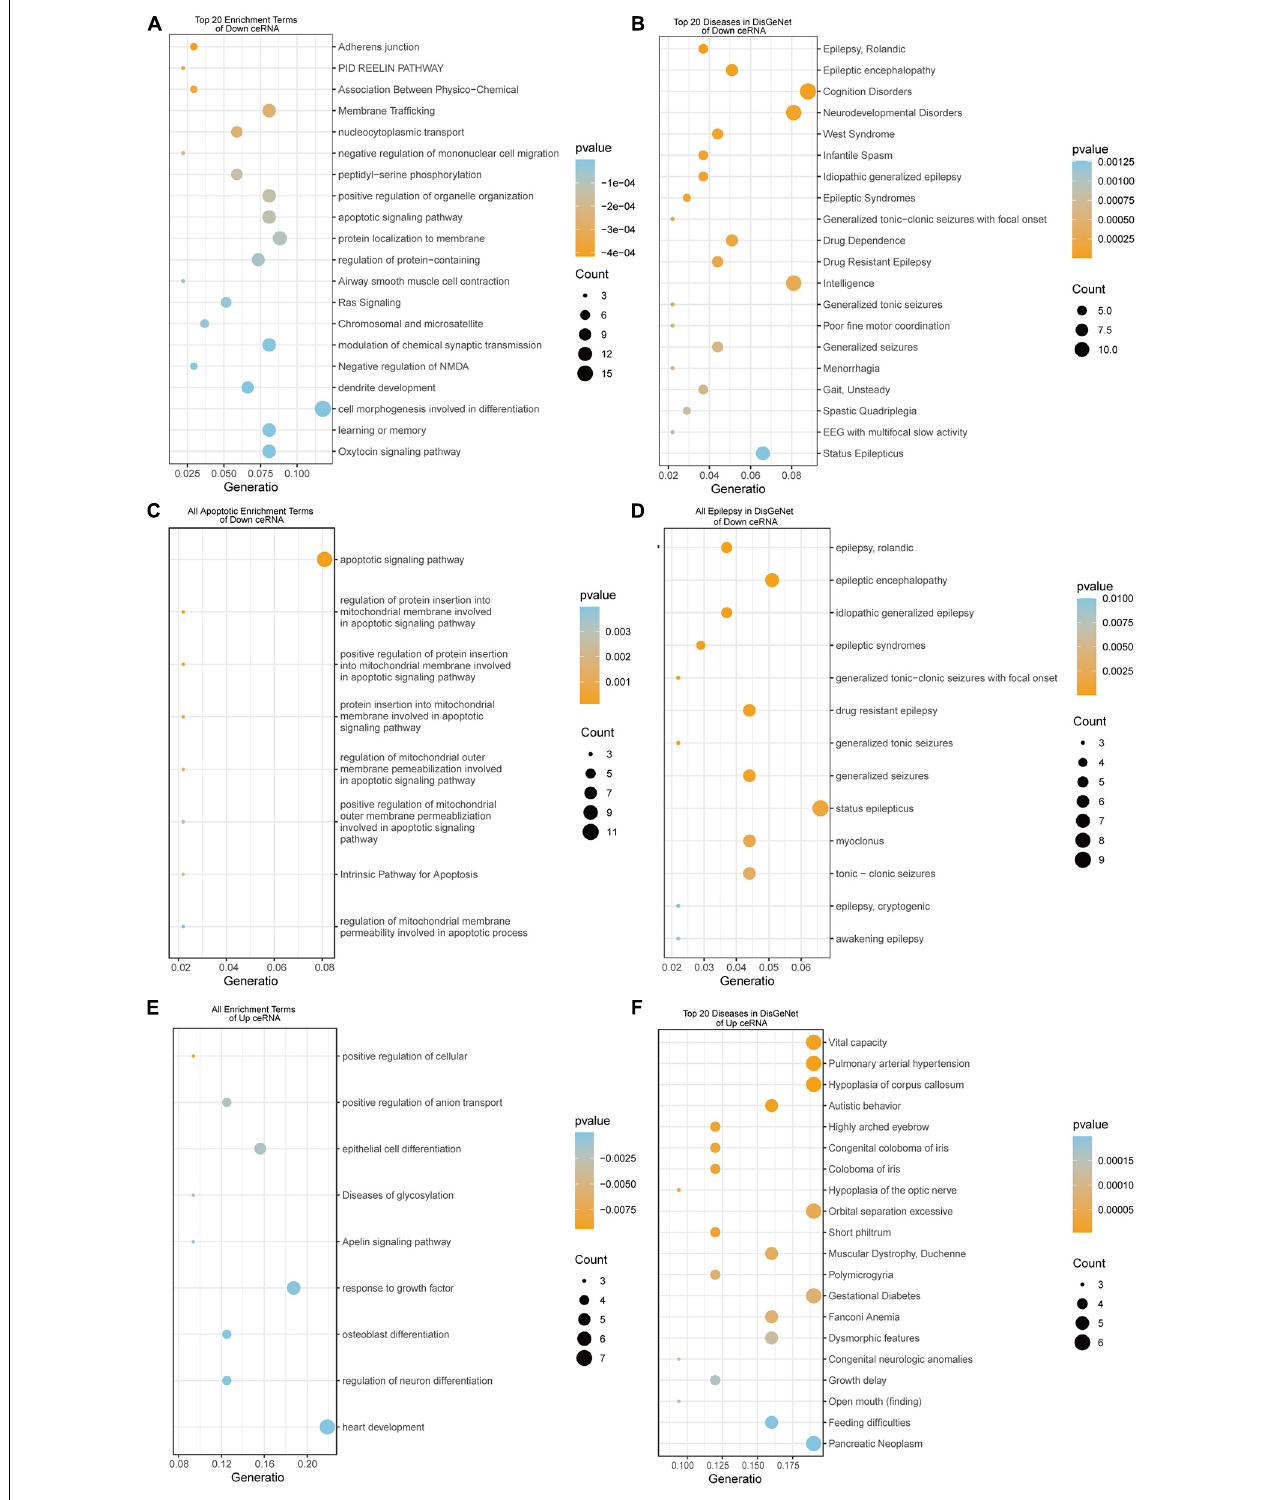
FIGURE 6 | The enrichment results of DEmRNAs in Down and Up ceRNA network. Down ceRNA network enrichment results (A–D) . (A) Top 20 enrichment results of GO, KEGG, and Reactome; (B) top 20 Diseases in DisGeNet; (C) all terms related to Apoptosis; (D) all types of epilepsy in DisGeNet. UP ceRNA network enrichment results (E,F) . (E) Top 20 enrichment results of GO, KEGG, and Reactome; (F) top 20 diseases in DisGeNet.